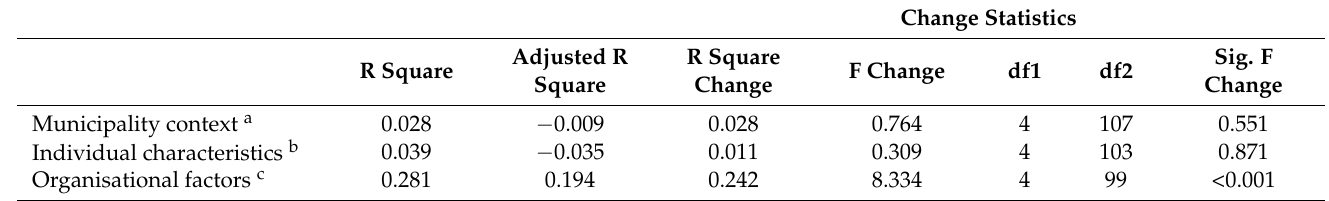
Table 5. Hierarchical linear regression analysis testing groups of variables relating to municipal context, individual characteristics and organisational factors on intersectoral agency ( n =